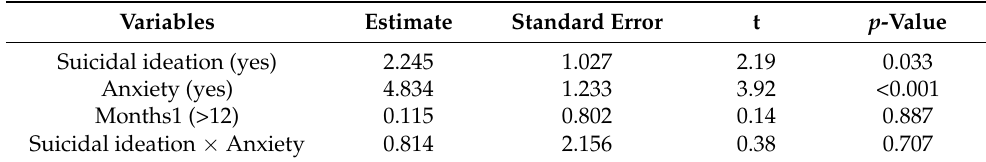
Table 3. Multivariate Regression analysis for Depression.